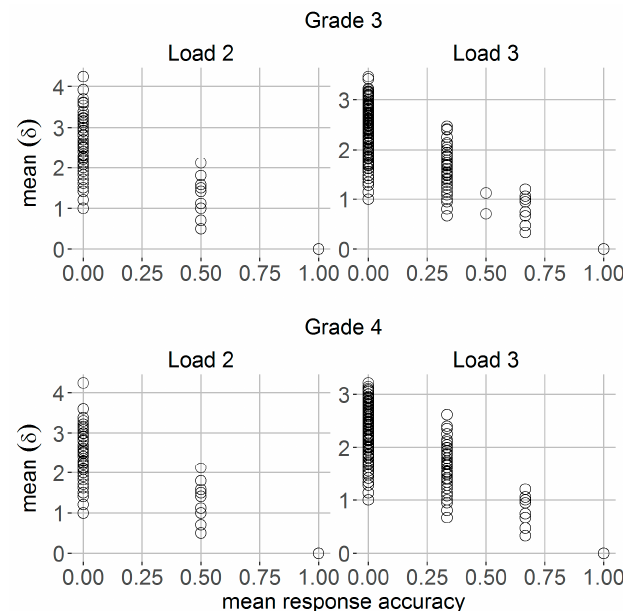
Figure 3. Trial-to-trial mean spatial precision (i.e., Euclidean distance δ ) (y-axis) as a function of mean response accuracy (x-axis) for Grade 3 (first row) and Grade 4 students (second row) and separately for loads two and three.